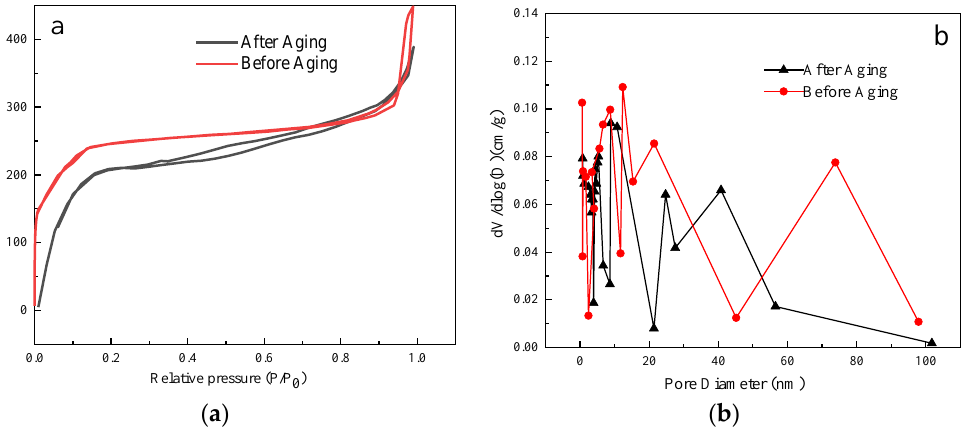
Figure 7. ( a ) Adsorption–desorption isotherm and ( b ) pore size distribution of ZIF before and